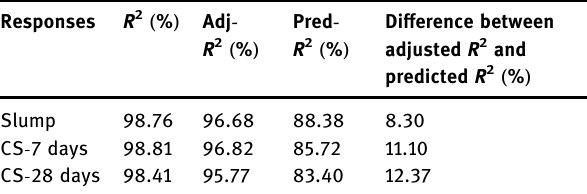
Table 6: Results for the statistical models